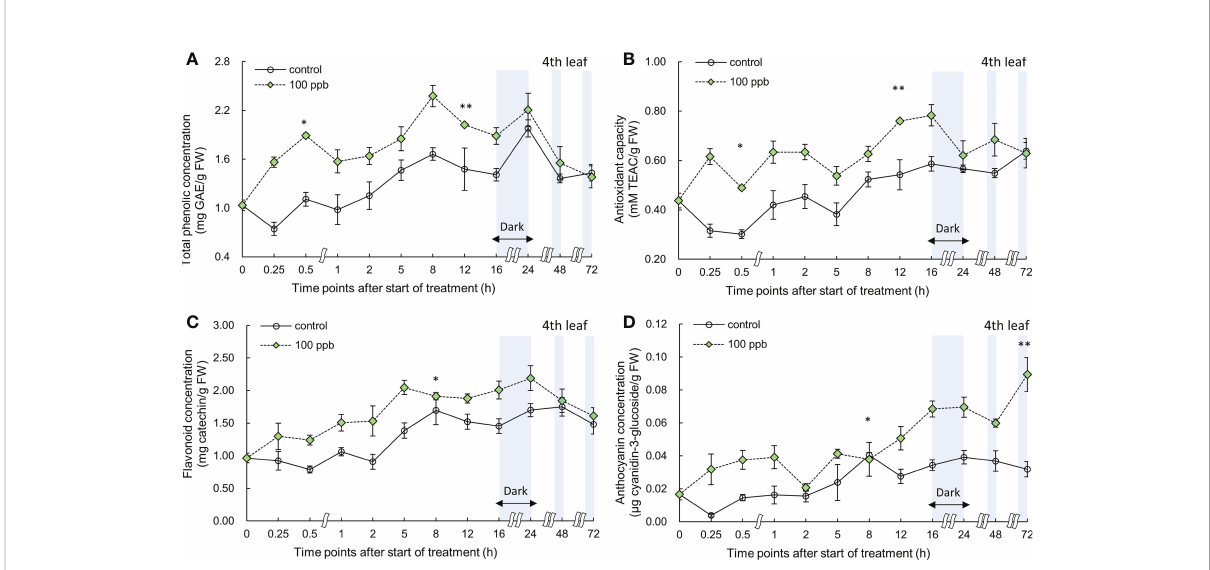
FIGURE 7 Total phenolic concentration (A) , antioxidant capacity (B) , total fl avonoid concentration (C) , and anthocyanin concentration (D) of fourth red leaf lettuce subjected to 100 − ppb ozone treatment for 72 h. The vertical vars indicate SE (n=4). Statistically signi fi cant differences are indicated at * p < 0.05 and ** p < 0.01 by